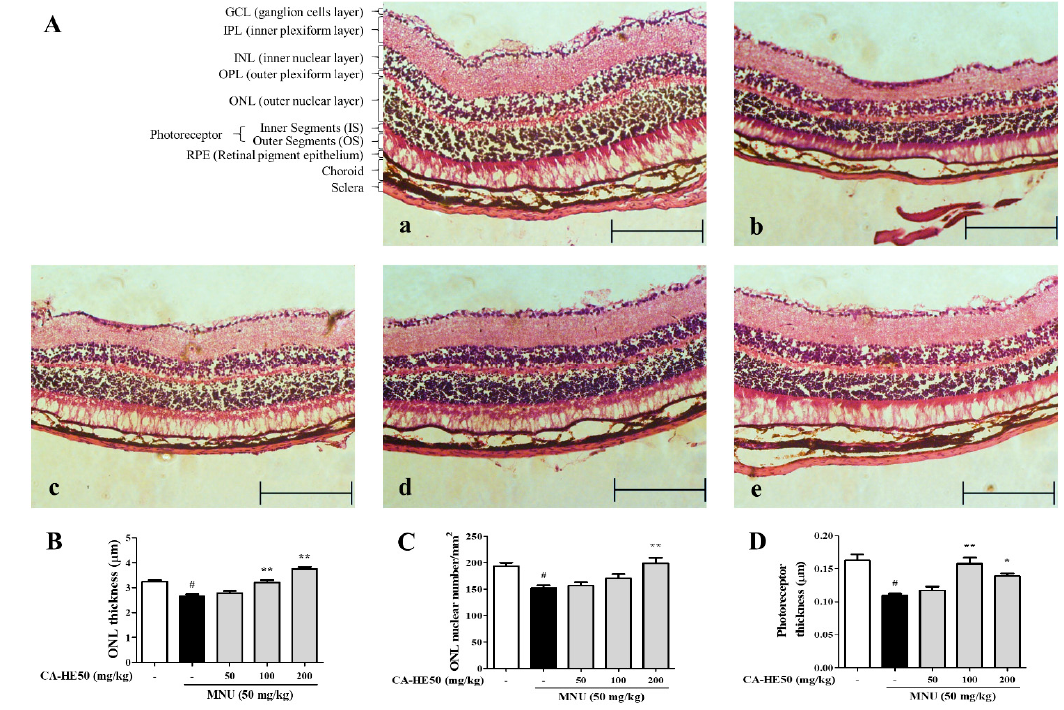
Figure 1. Histopathology images of retinas with H&E staining from five groups of mice 24 h post-injection of MNU. ( A ) Images of H&E staining of a retinal section from mice: ( a ) representative image of H&E staining of a retinal section from control mice (not injected with MNU); ( b ) representative image of H&E staining of a retinal section from MNU/vehicle mice (MNU-injected and saline administered); ( c ) representative of H&E staining of a retinal section from low-dose CA-HE50–administered mice (50 mg/kg CA-HE50 for seven days and then injected with MNU); ( d ) representative image of H&E staining of a retinal section from middle-dose CA-HE50–administered mice (100 mg/kg CA-HE50 for seven days and then injected with MNU); and ( e ) representative image of H&E staining of a retinal section from high-dose CA-HE50–administered mice (200 mg/kg CA-HE50 for seven days and then injected with MNU). Data are representative of six independent animals. ( B ) ONL thickness. ( C ) ONL nuclear numbers. ( D ) photoreceptor thickness. # p < 0.05 vs. normal control group. * p < 0.05 and ** p < 0.01 vs. MNU-treated group. Abbreviations: MNU, N -methyl- N -nitrosourea; GCL, ganglion cell layer; IPL, inner plexiform layer; INL, inner nuclear layer; OPL, outer plexiform layer; ONL, outer nuclear layer; IS, inner segments; OS, outer segments; RPE, retinal pigment